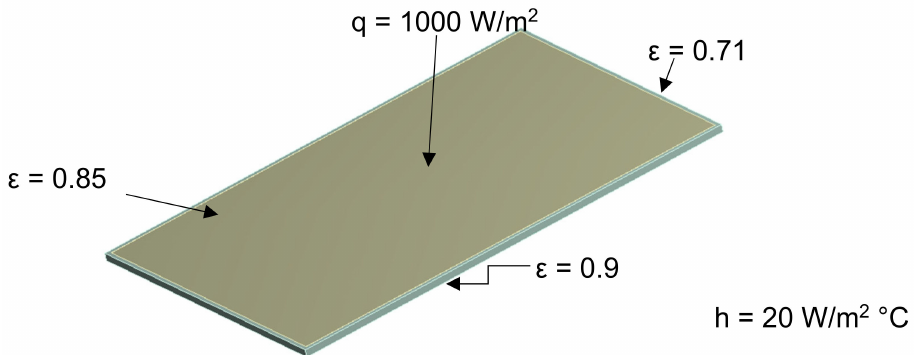
Figure 5. Boundary conditions used in the thermal analysis.